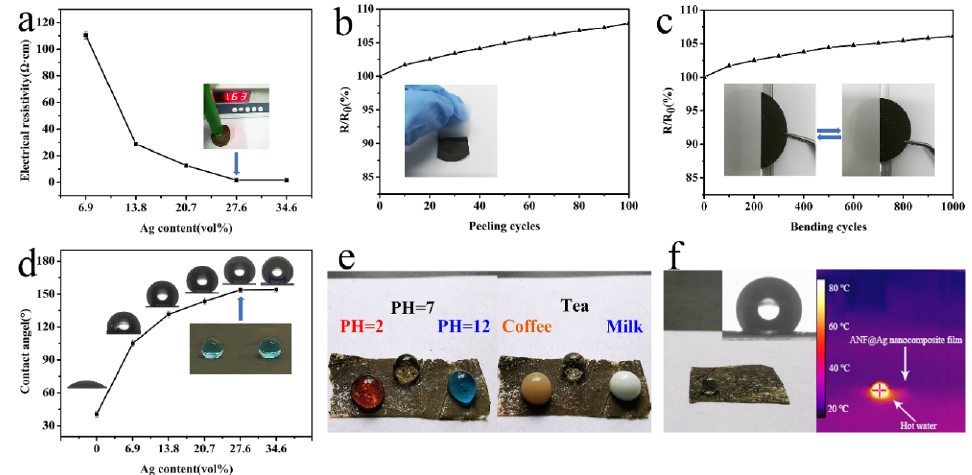
Figure 7. ( a ) Effects of Ag content on the electrical conductivity of the ANF@Ag nanocomposite film; ( b ) effects of adhesion ‐ peeling cycles ( the inset shows that an adhesive tape is used to adhere and peel off from the nanocomposite film ) and ( c ) bending–unbending cycles (the inset shows that the nanocomposite film wraps around a glass rod) on the changes of the sheet resistance of the ANF@Ag nanocomposite film ; ( d ) effects of Ag content on the contact angle of the ANF@Ag nanocomposite film (the inset shows water droplets on the surface of the film ) ; ( e ) digital photographs of solutions with pHs of 2, 7 and 12 and three common drinks including coffee, tea and milk on the surface of the ANF@Ag nanocomposite film; and ( f ) digital photograph and IR image of a hot water droplet on the surface of the ANF@Ag nanocomposite film. As pressure sensors are usually applied in environments with a high humidity (e.g., sweat and rain), it is significant to endow the sensors with superhydrophobicity. Figure 7d shows the contact angles of the ANF@Ag nanocomposite films with different Ag con ‐ tents. Obviously, the ANF film with a contact angle of 43.8 ± 1.5° was hydrophilic and would absorb water easily. After the introduction of the Ag NPs (6.9 vol%), the surface of the film became hydrophobic with a contact angle of 105.1 ± 1.5°. When the Ag content increased to 27.6 vol%, the surface of the film exhibited superhydrophobicity with a con ‐ tact angle of 153.9 ± 1°. With a hierarchical roughness derived from Ag NPs, like the mas ‐ toid structure of a lotus leaf (Figure S5), the micro/nano hierarchical structures increase surface roughness dramatically so that air can be trapped in the aperture of Ag NPs and nanofibers, even below water droplets, and thus reduce the liquid–solid contact and cause superhydrophobicity. Besides the low surface energy derived from PDMS, this was also a key factor for constructing the superhydrophobic surface. When acid (red, pH = 2), pure water (transparent, pH = 7), alkaline (blue, pH = 12) and three common drinks including coffee, tea and milk were dripped on the surface of the ANF@Ag nanocomposite film (27.6 vol%), spherical droplets steadily stood on it, demonstrating good corrosion resistance (Figure 7e). Interestingly, the ANF@Ag nanocomposite film revealed hot water repellency (Figure 7f). The IR image of a hot water droplet (70 °C) on the surface of the ANF@Ag nanocomposite film showed a contact angle of 151.3 ± 1.1°, which was similar with that of a room ‐ temperature water droplet on the surface of the nanocomposite film. This